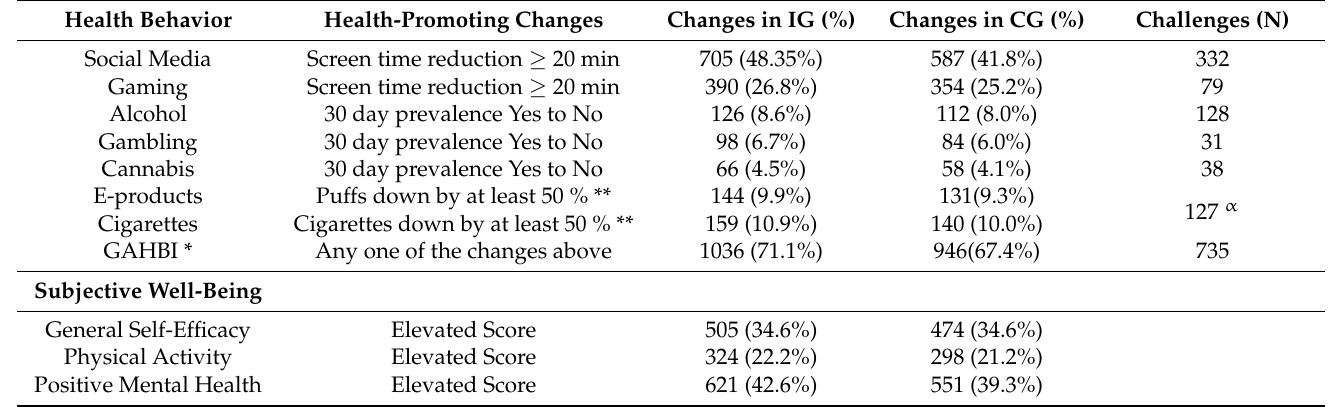
Table 2. Assessed behavioral and well-being variables, criteria on which a health-promoting change from baseline to follow-up was defined, distribution of these changes in the IG and CG, and challenges started in each area (IG only).